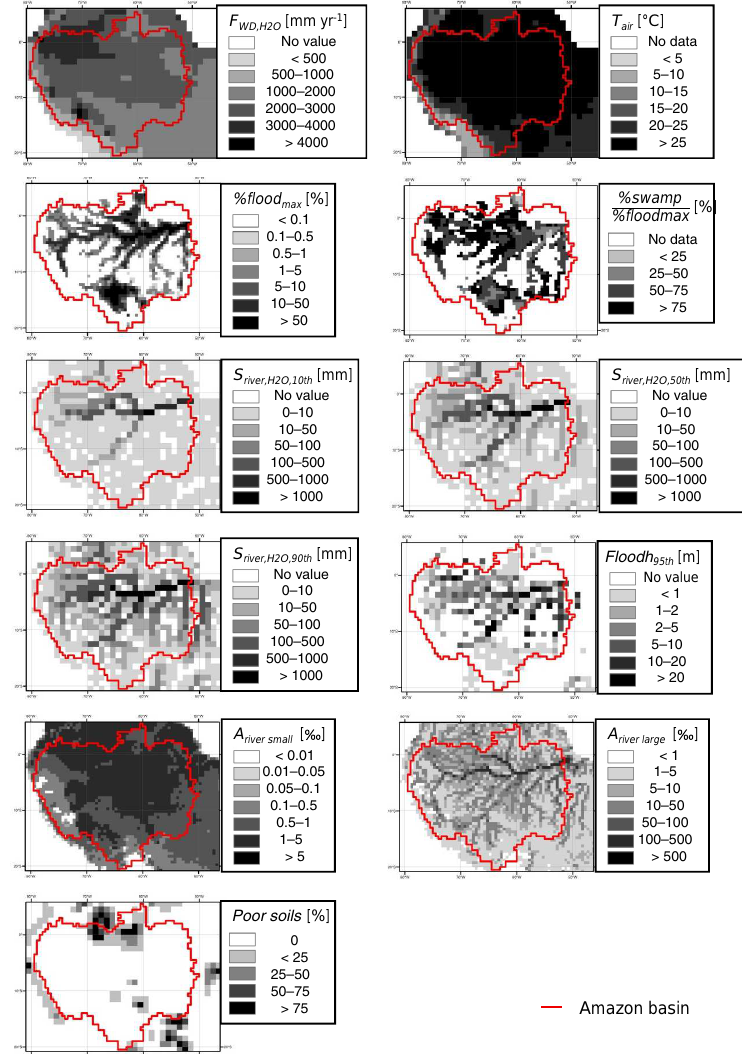
Figure 6. Overview of forcing files (see Table 2). Climatic forcings are comprised of, among others, variables like precipitation ( F WD , H and air temperature ( T air ). The climatic forcings used here are based on the NCC (Ngo-Duc et al., 2005) data set, except that F WD , H replaced by a regional data set created by Guimberteau et al. (2012). The forcing of maximum floodable areas %flood max was adopted from Guimberteau et al. (2012) after merging swamp areas (%swamp) into %flood max . Simulations of inundation in ORCHILEAK are based on 10th, 50th and 90th percentiles of water storage in the river reservoir S river (S river , H in millimetres which equals kilograms of H 2 O per squared metre assuming a density of water of 10 − 3 kgm − 3 , and the 95th percentile of water table level over the floodplains floodh (floodh 95th ), all derived from simulation results over the period 1980 to 2000. Surface areas of small (width < 100m) and large (width ≥ 100m) rivers ( A riversmall , A riverlarge ) are taken from Lauerwald et al. (2015). Of importance for representation of DOC cycling in watersheds of black-water rivers is the identification of “poor soils” (Podzols, Arenosols and soils in black-water swamps), which we derived from the Harmonized World Soil Database (HWSD, FAO/IIASA/ISRIC/ISS-CAS/JRC, 2009) and